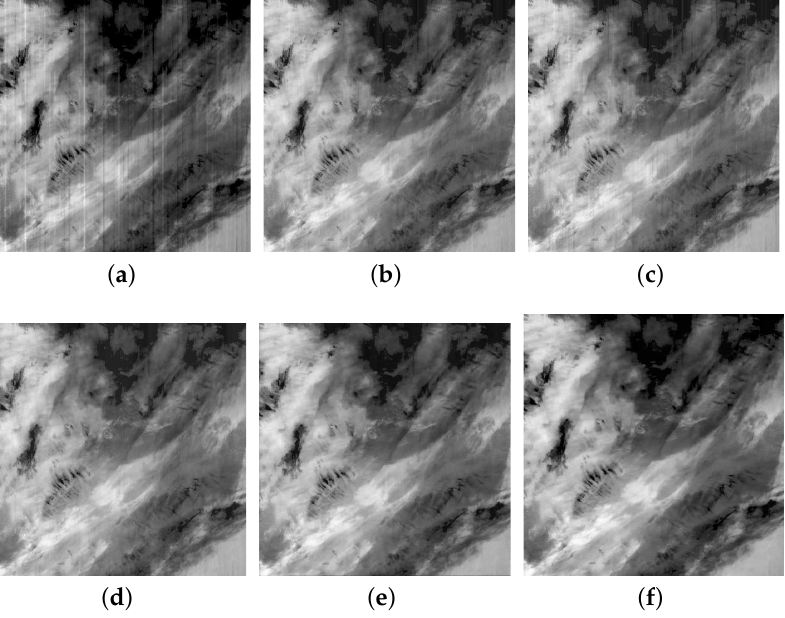
Figure 8. Destriping results of nonperiodic stripes in Terra MODIS band 34. ( a ) Original image;